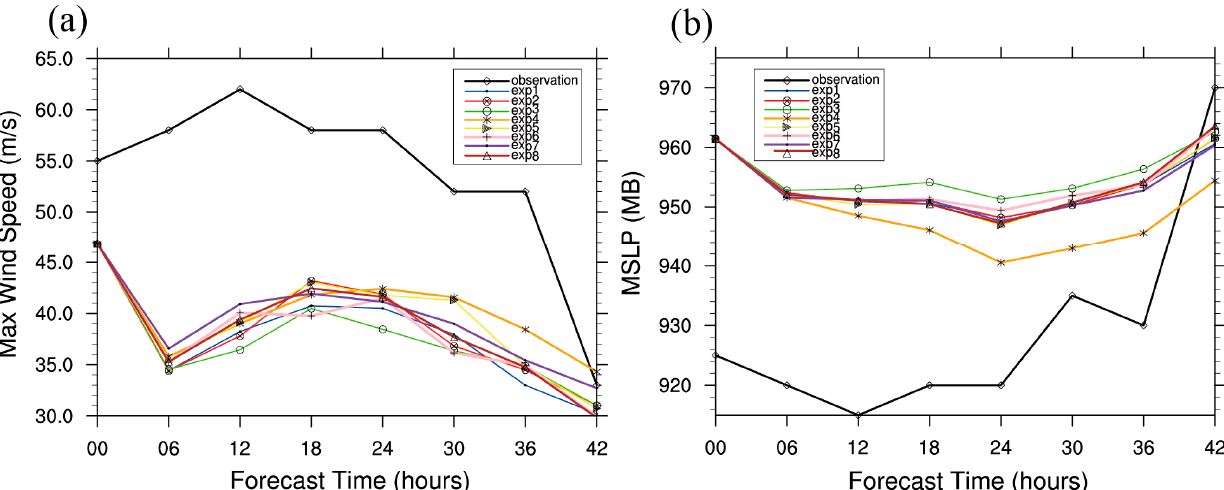
Figure 5. ( a ) Max wind speed (units: m/s) and ( b ) minimum sea level pressure (units: MB) forecast errors by lead time from 0600 UTC 8 August to 0000 UTC 10 August 2019, initialized at 0600 UTC 8 August 2019 for the eight different sensitivity experiments.